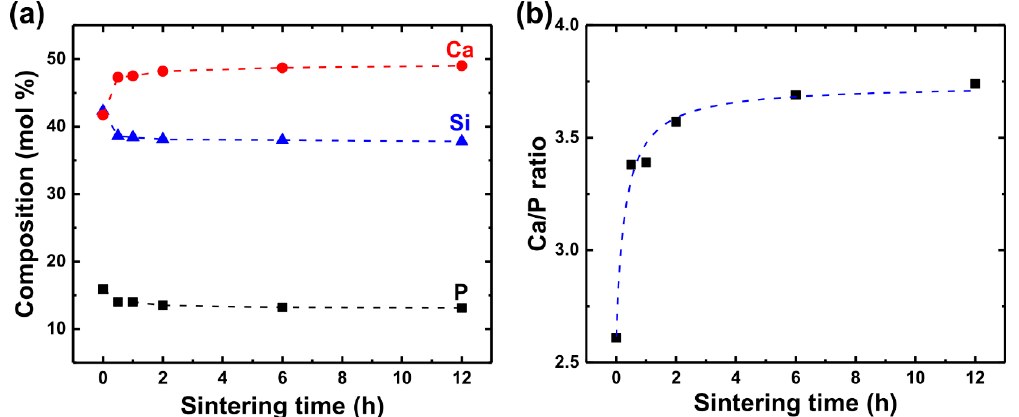
Figure 7. Changes in the ( a ) chemical composition and ( b ) Ca/P ratio of LMSP samples against the sintering time.